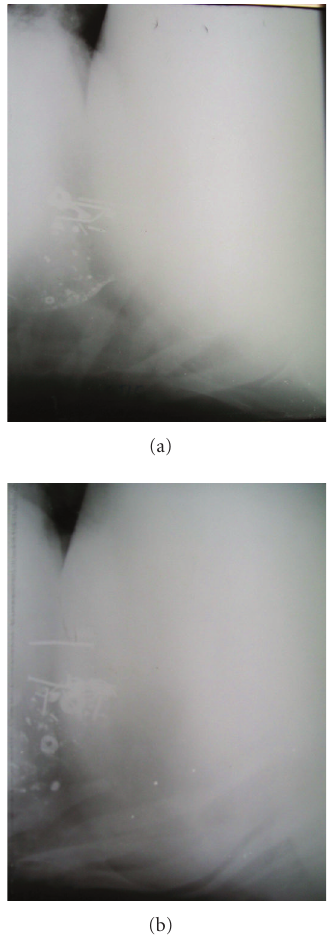
Figure 2: Lateral radiographs of reticulum showing indistinct diaphragmatic line and presence of metallic densities in a sac-like structure cranial to